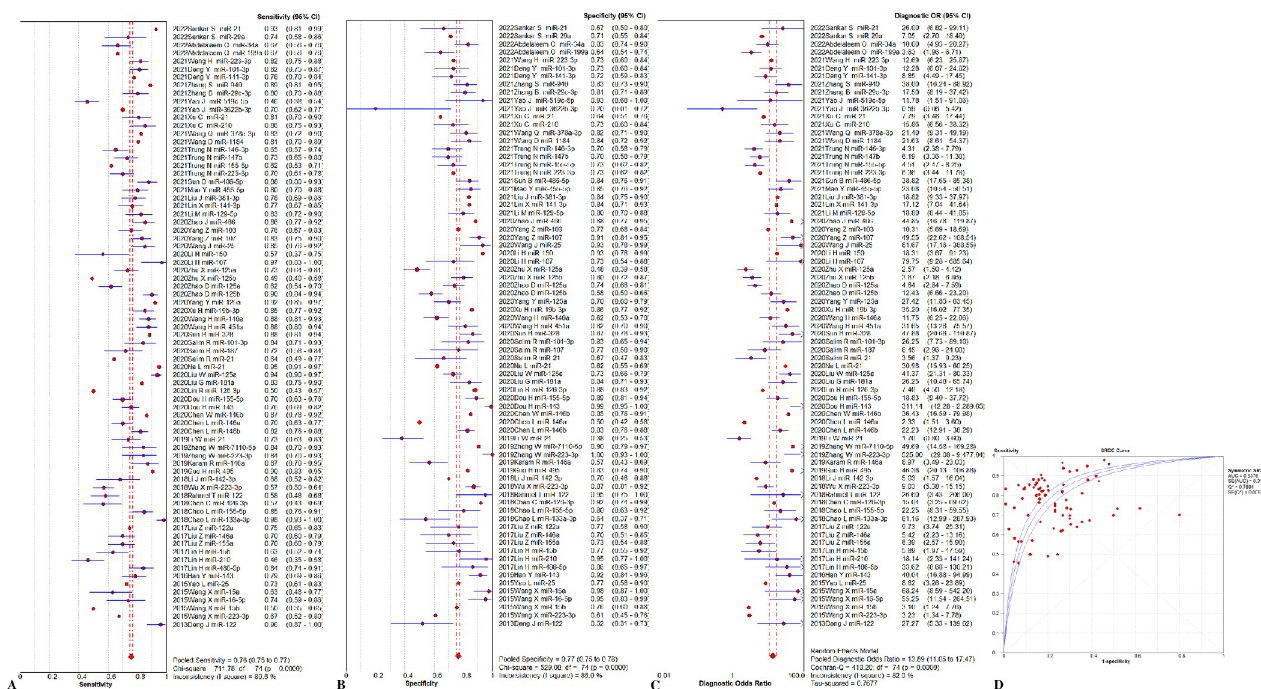
Fig 2. Performance of total miRNAs detection for sepsis diagnosis. (A) Pooled sensitivity. (B) Pooled specificity. (C) Overall DOR. (D) The SROCs for all datasets. CI = confidence interval, DOR = diagnostic odds ratio, miR = mircoRNA, OR = odds ratio, SROC = summary receiver operating characteristic curves